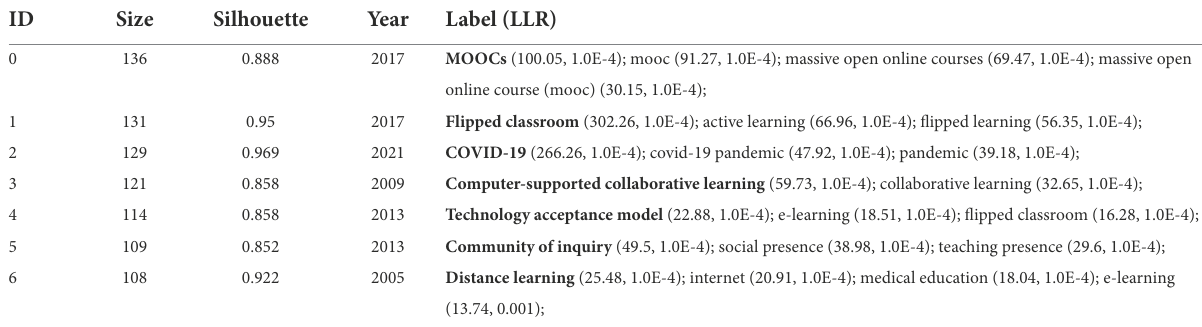
TABLE 5 Details of knowledge